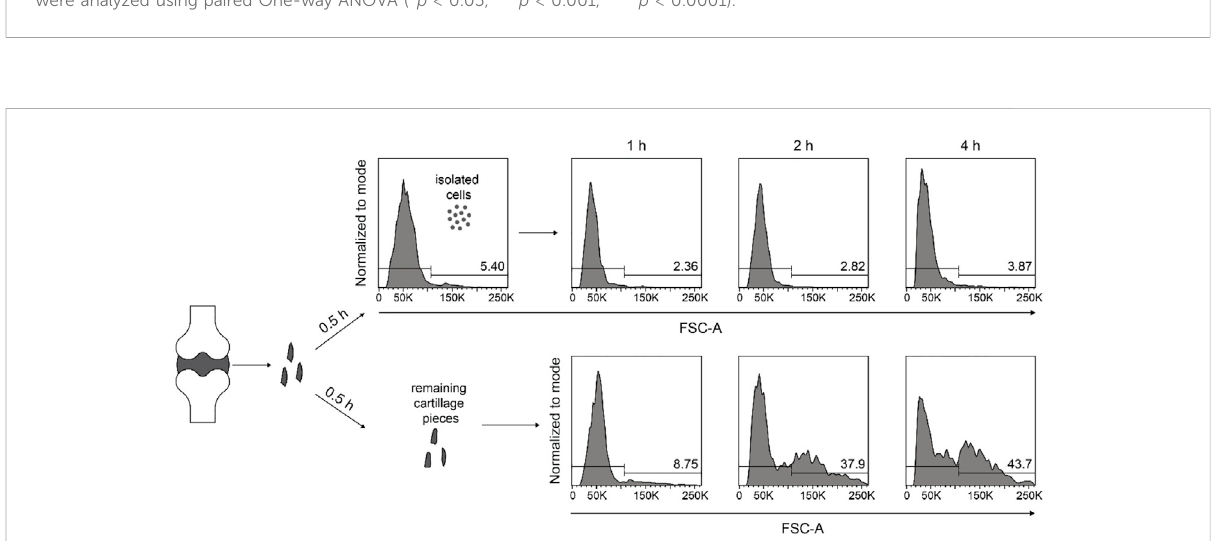
FIGURE 5 Large chondrocytes do not arise from the small cells during the isolation procedure. Human articular cartilage tissue was minced fi nely and digested with2%collagenase IIfor0.5 h.Releasedcellsandundigestedcartilage tissuewereseparatebyacellstrainer,transferredintotwoseparate tissue culture tubes, and both samples were replenished with medium containing 2% collagenase II, and were kept at 37 ° C under constant rotation. After another 0.5, 1.5, and 3.5 hof further digestion, both samples weresubjected to cell harvesting, and the cell sizes weredetermined at